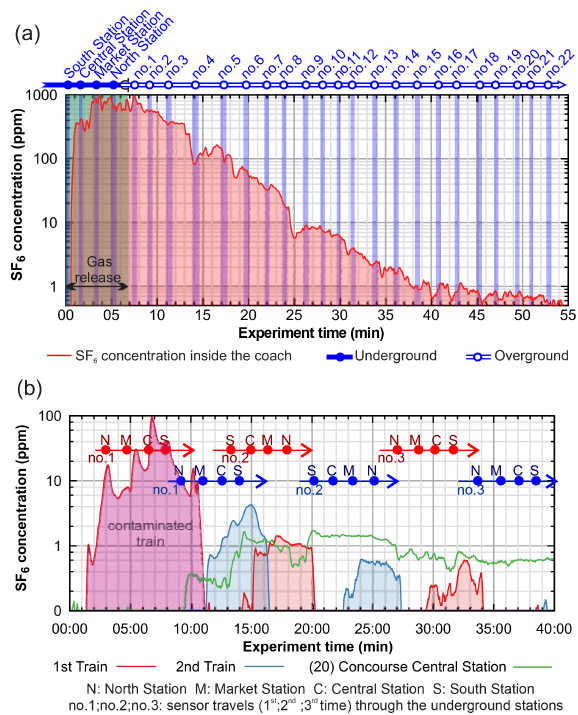
Figure 7. (a) Remaining concentration level inside a subway train after the initial gas release; (b) contamination of running subway trains while passing the contaminated underground track and of the concourse level at Central Station (see Fig.